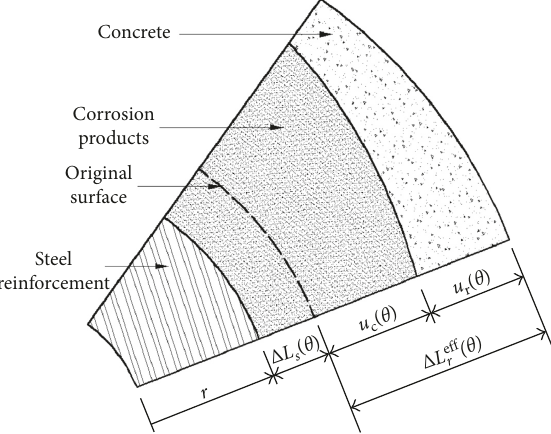
Figure 2: Rust expansion displacement relationship